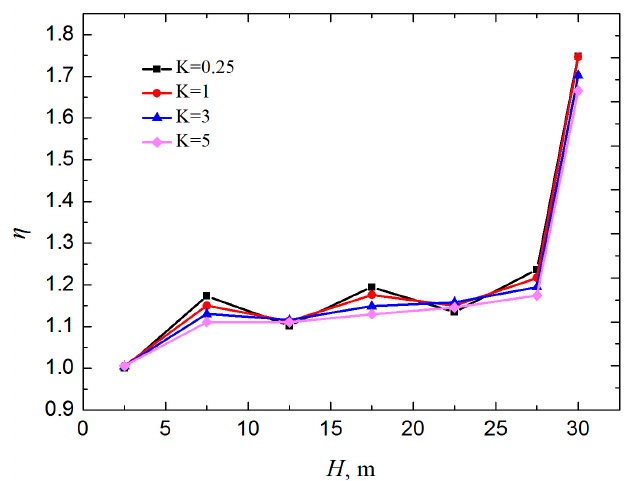
Figure 9. The acceleration amplification coefficient of monitoring points on the slope surface with different K ( K = 0.25 to 5) (where ξ = 0.4).